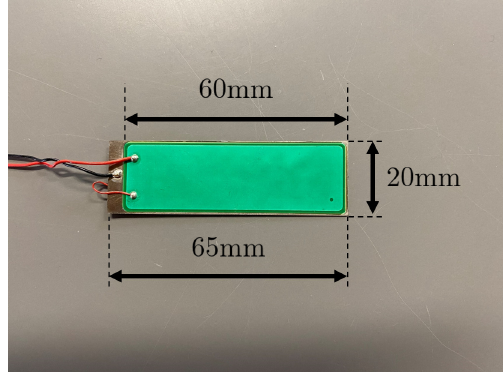
Figure 1. The piezoelectric bimorph actuator